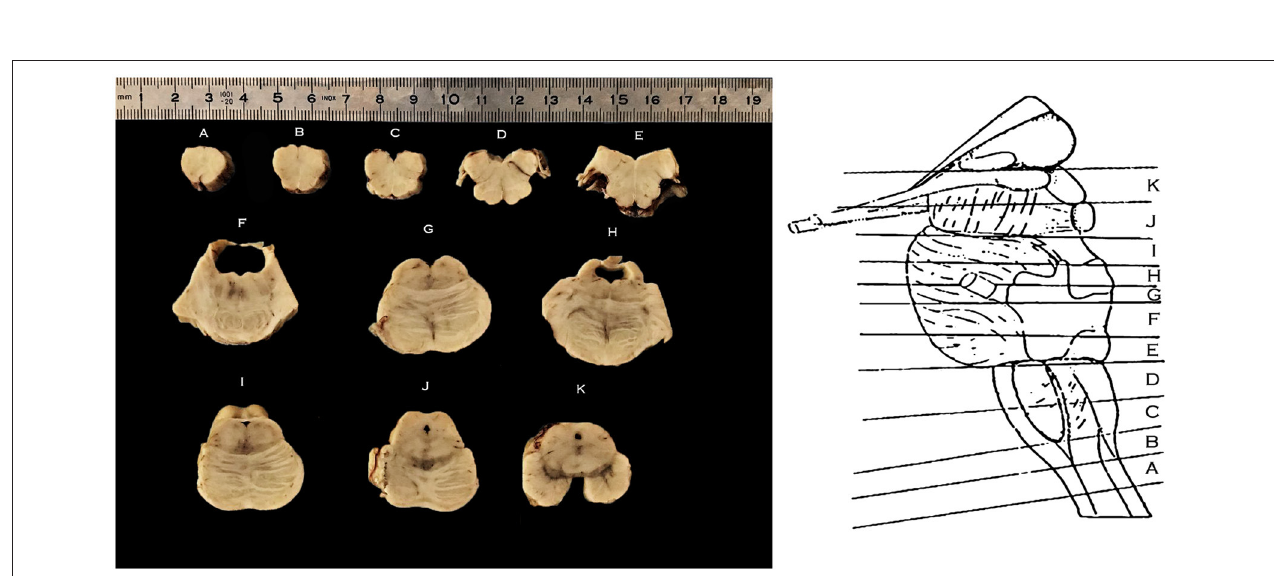
FIGURE 2 | Right, schematic representation of the levels of sectioning of the Human Brainstem, lateral perspective following isolation of the cerebellum; Left, axial sections of the brainstem according to the schema on the right; caudal surface facing upwards. From caudal to cranial: (A) section at the level of the decussation of the pyramids; (B) section at the level of the sensory decussation; (C) section at the level of the inferior half of the medullary olivary complex; (D) section at the level of the superior half of the medullary olivary complex; (E) section at the level of the caudal pons and the colliculus facialis; (F,G) section at the level of the intermediate pons; (H,I) section at the level of the cranial pons; (J) section at the level of the mesencephalo-pontine sulcus; (K) section at the level of the mesencephalon.